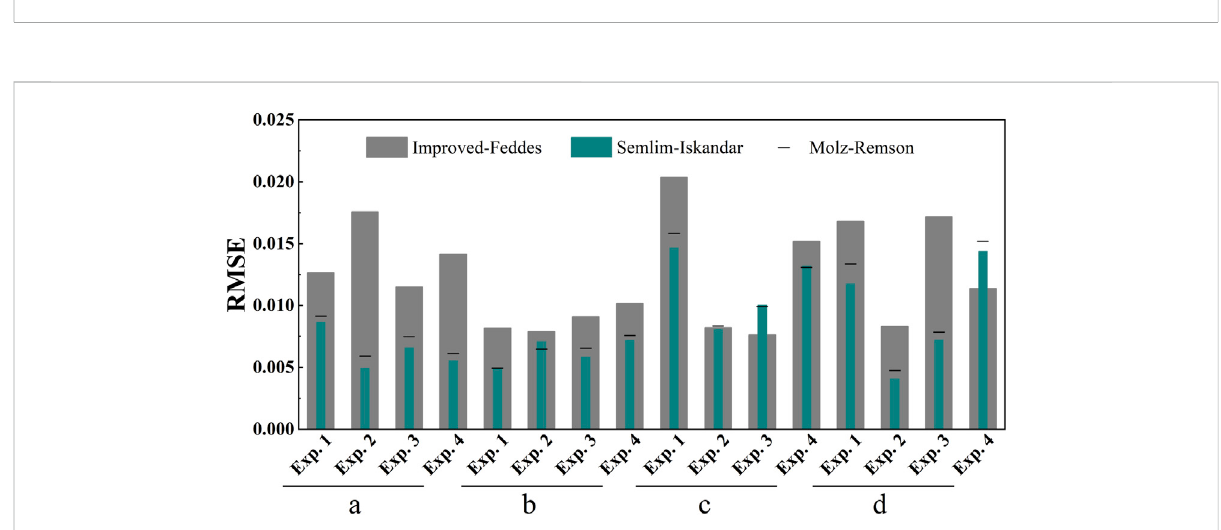
FIGURE 5 EMSE comparison chart. RMSE between the measured values of soil water content at each experimental location at different experimental times, and the simulated values predicted by three macroscopic root water uptake models combined with the soil water equation of